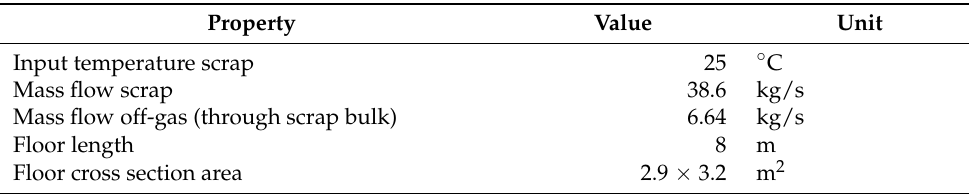
Table 2. Operating data for modeled scrap bulk shaft.